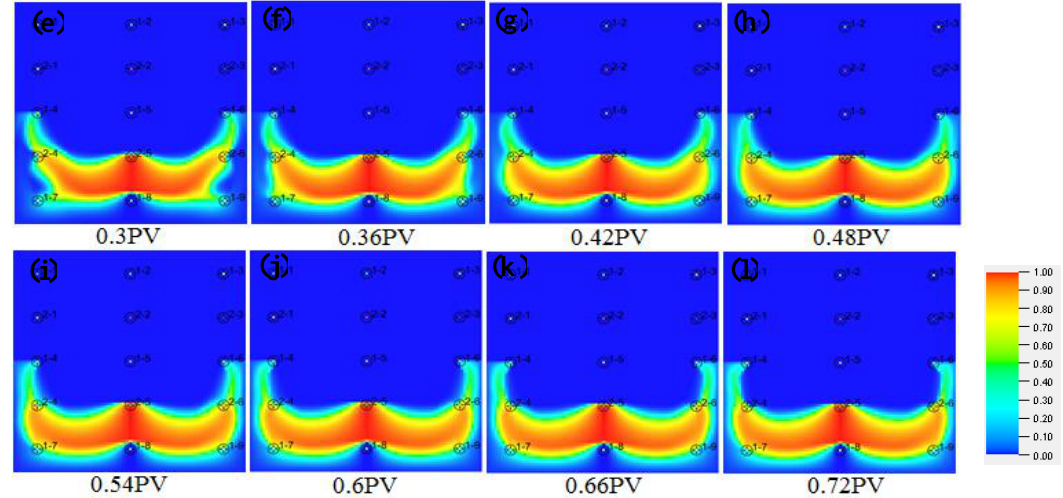
Figure 7. The water ( a ) injected, 0.06 PV, ( b ) injected, 0.12 PV, ( c ) injected, 0.18 PV, ( d ) injected, 0.24 PV, ( e ) injected, 0.3 PV, ( f ) injected, 0.36 PV, ( g ) injected, 0.42 PV, ( h ) injected, 0.48 PV, ( i ) injected, 0.54 PV, ( j ) injected, 0.6 PV, ( k ) injected, 0.66 PV, and ( l ) injected, 0.72 PV tracer diagrams of the well 2-5.